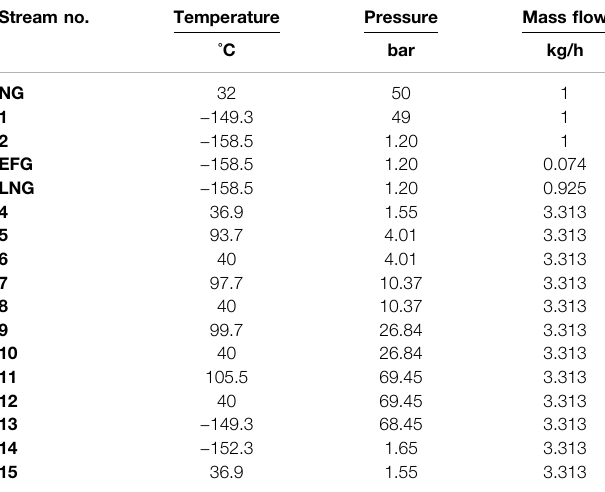
TABLE 2 | Process stream conditions of the SMR-LNG process. TABLE 1 | Design parameters and constraints of the SMR-LNG